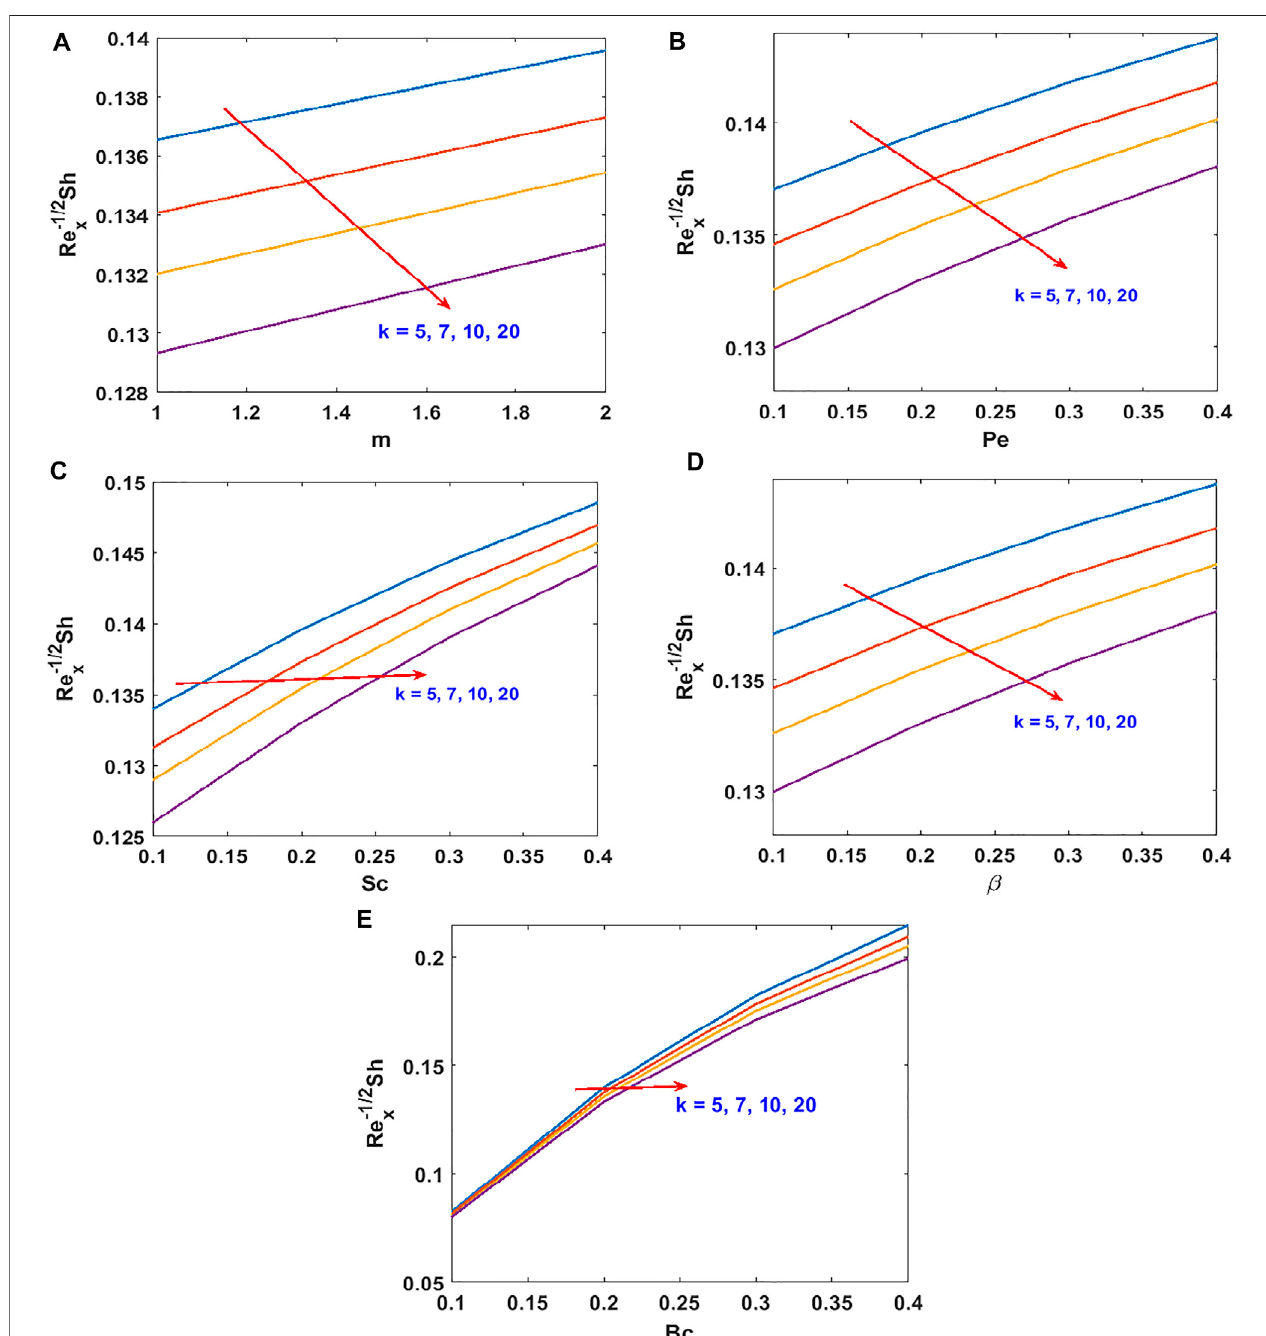
FIGURE 9 | Variation of rate of mass transfer on curvature parameter k against m, Pe, Sc, β , and Bc.